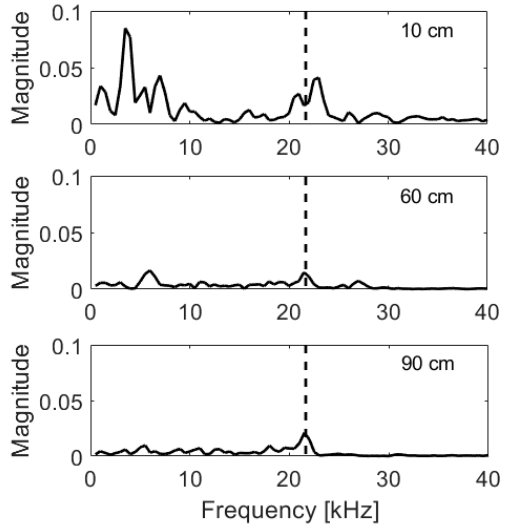
Figure 3. Frequency spectra of measurements taken at a large span floor in distance of 10 cm, 60 cm and 90 cm from impactor; frequency due to thickness marked with dashed line.